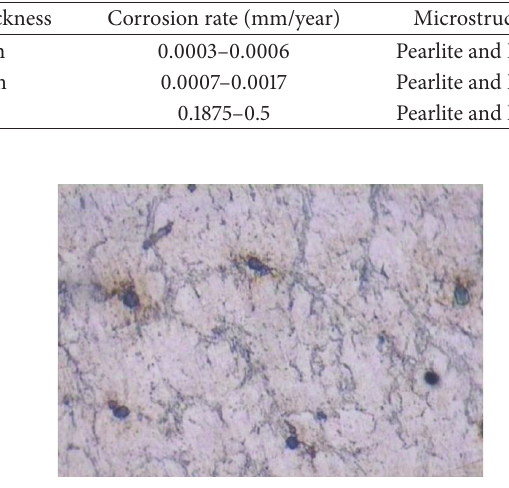
Figure 18: Microstructure with 500x magnification of rebar taken from core